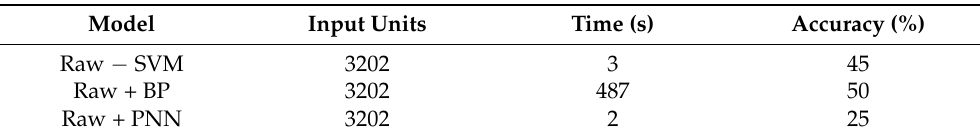
Table 1. Support vector machine, BP neural network and probabilistic neural network resistant-rice- classification models established using original Ranman